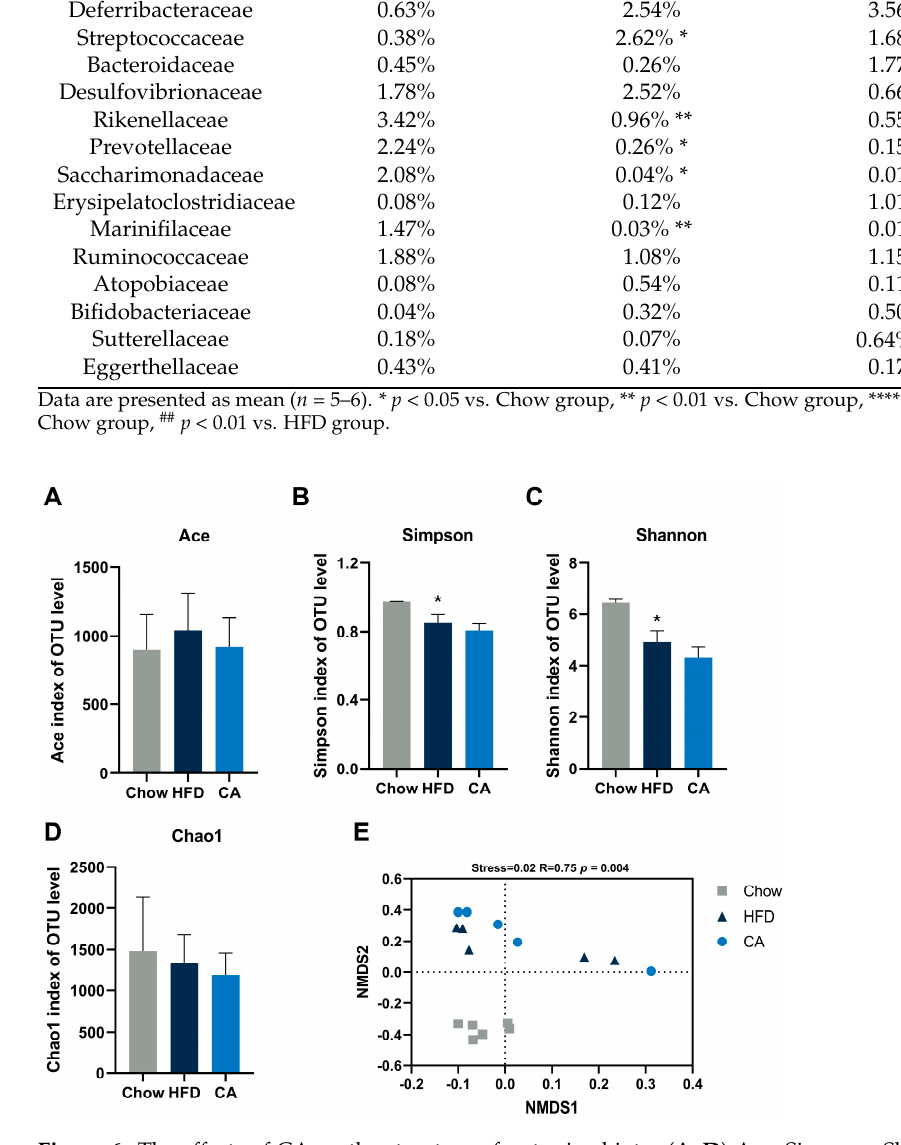
Figure 6. The effects of CA on the structure of gut microbiota. ( A – D ) Ace, Simpson, Shannon, and Chao1 indexes. ( E ) NMDS with weighted UniFrac distance; significant differences were assessed using adonis PERMANOVA. Data are expressed as means ± SEM ( n = 5–6). * p < 0.05 vs. Chow group.